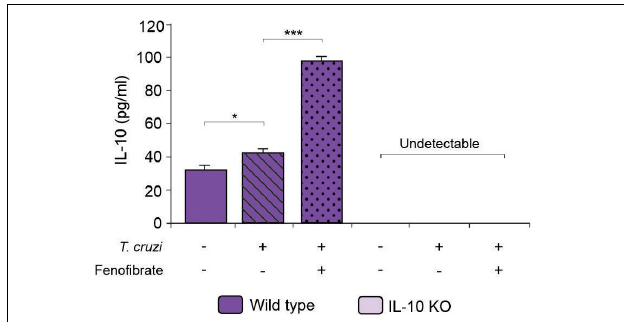
FIGURE 2 | Determination of IL-10 concentration in sera. Concentration of IL-10 was measured by ELISA in sera from uninfected, T. cruzi -infected, and T. cruzi -infected fenofibrate-treated WT and IL-10 KO mice. Differences between groups were analyzed by ANOVA (mean ± SEM) followed by Tukey post hoc test. Differences were considered significant when p < 0.05. N = 7 mice per group, 3 replicate experiments. * p < 0.05 and *** p < 0.001.